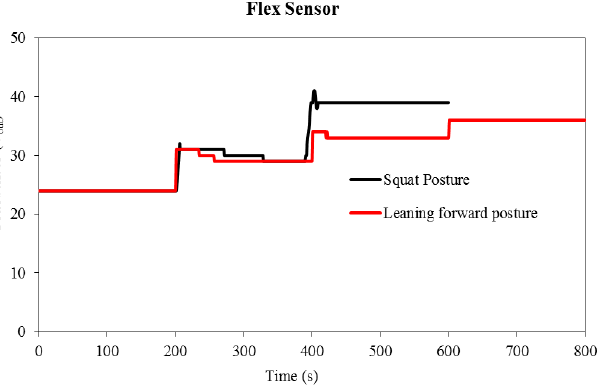
Figure 7. Flex sensor response against time during leaning forward and squat postures.